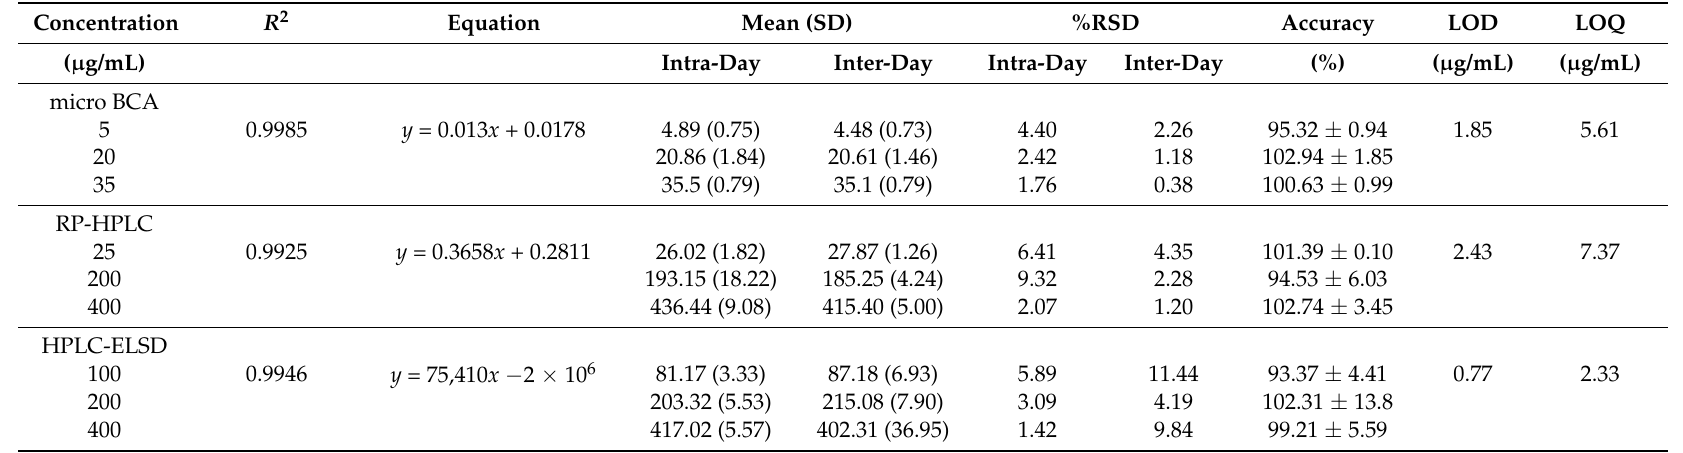
Table 2. A comparison of three protein quantification techniques; micro BCA, RP-HPLC, and HPLC-ELSD. For all three methods, the accuracy was determined at three concentrations, while Intra-day and Inter-day precision was calculated across three different concentrations with %RSD shown. The LOD and LOQ were also determined for the respective quantification techniques. Results represent the average of at least three replicate measurements ± standard deviation